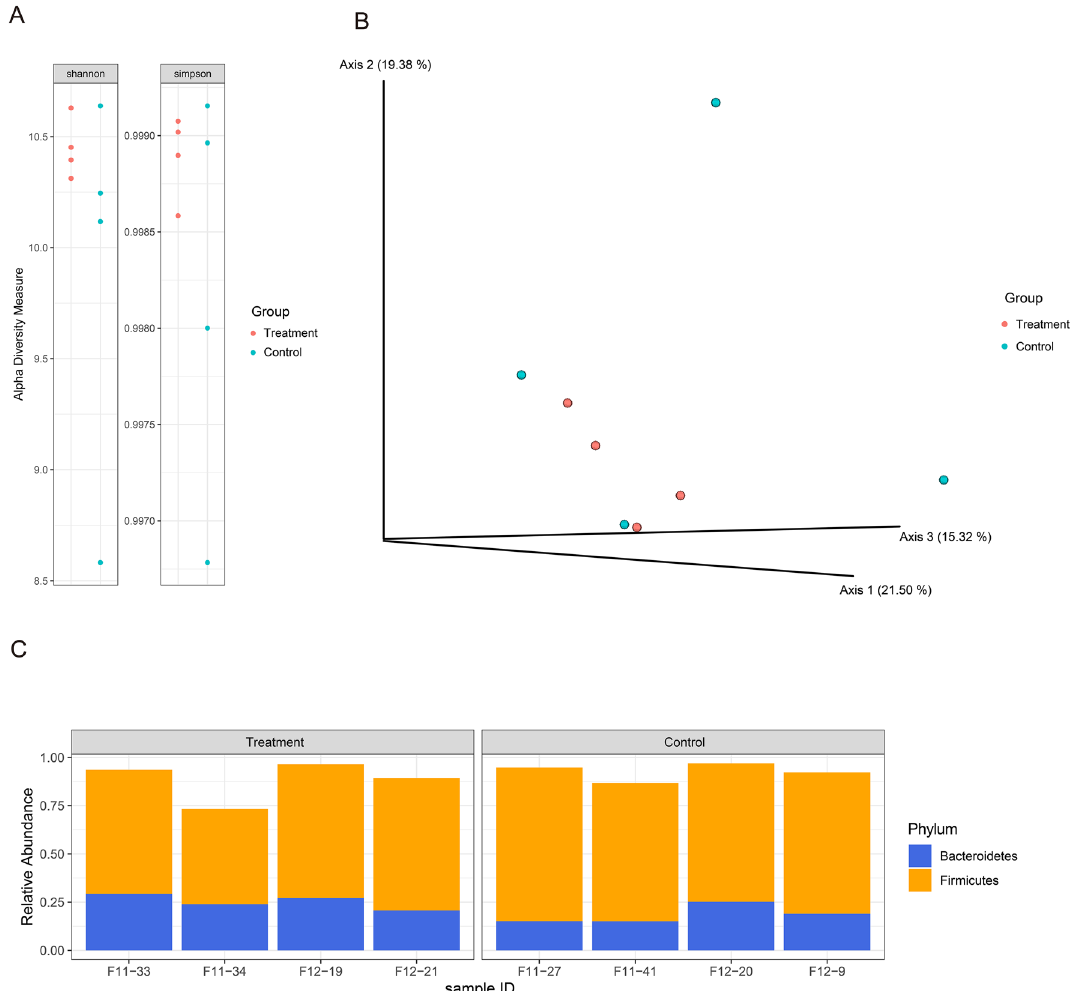
Figure 1. Microbiome profiling results from 16S rRNA gene amplicon sequencing. ( A ) Alpha diversity of the microbial communities within samples in the study groups. ( B ) Principal coordinate analysis (PCoA) plot of the beta diversity based on the Bray–Curtis dissimilarity index between microbial community samples in the study groups. ( C ) Relative composition of the two dominant phyla based on taxonomic analysis of the 16S rRNA amplicon sequence